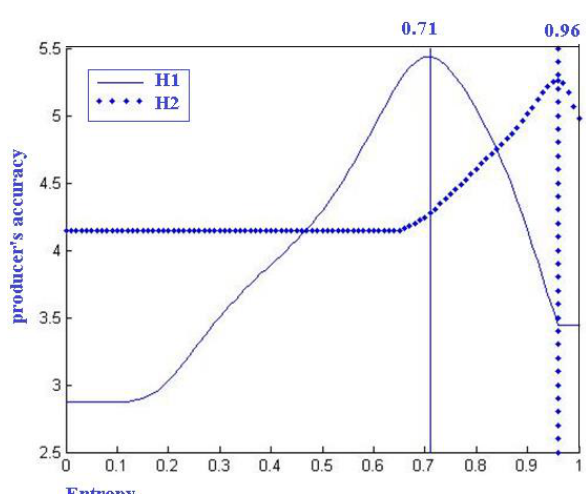
Fig.4. mean producer’s accuracy versus different values of the H1 and H2 boundaries.